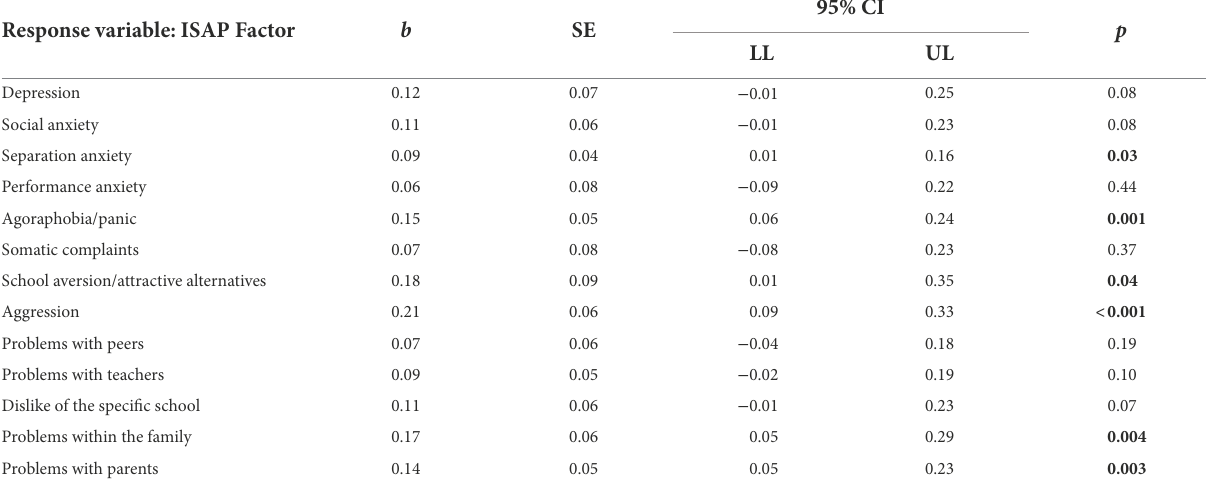
TABLE 5 Comparison of the reasons (ISAP F) for SAP between adolescents with ADHD and neurotypical adolescents per ISAP Factor in multivariate